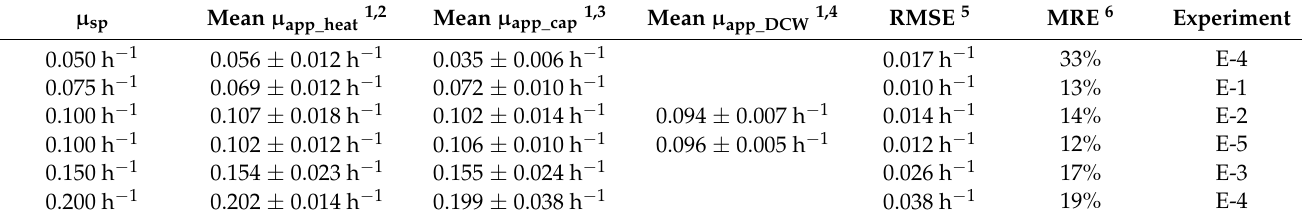
Table 1. Summary of the specific growth rates calculated for the five experiments performed.